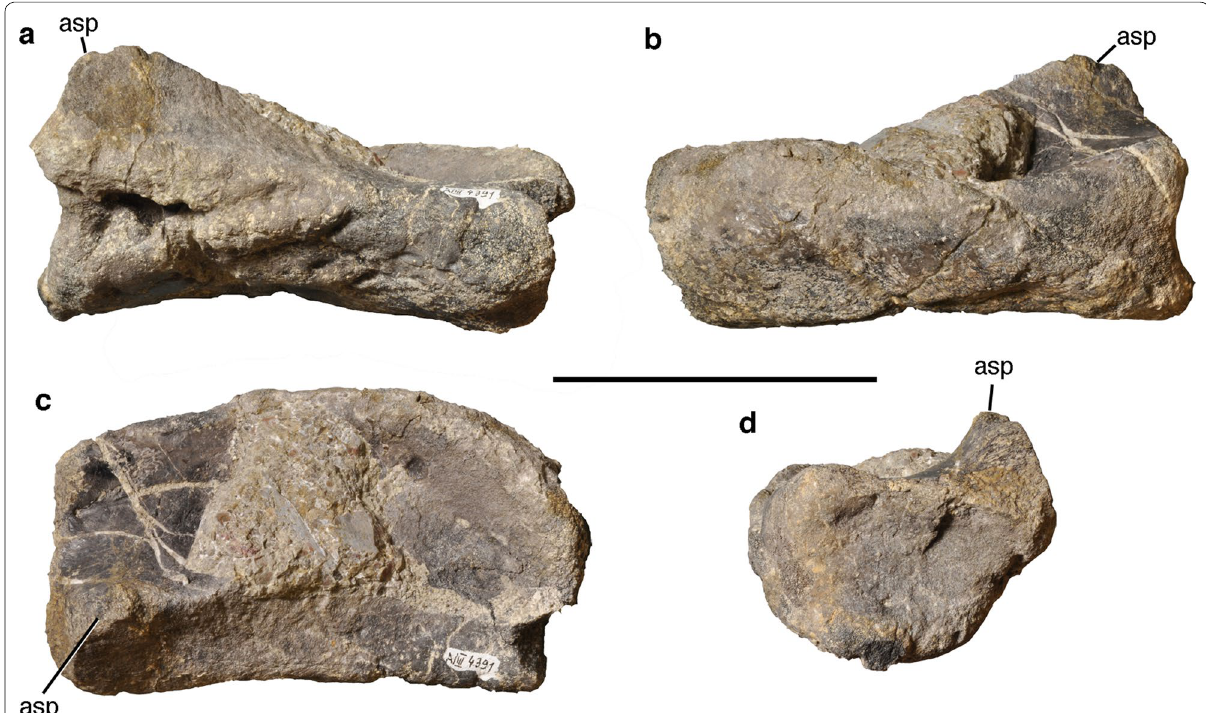
Fig. 13 Right astragalus of Plateosaurus sp. from Schleitheim-Santierge, PIMUZ A/III 4391. a Anterior view; b posterior view; c proximal view; d lateral view. asp, ascending process. Scale bar equals 10